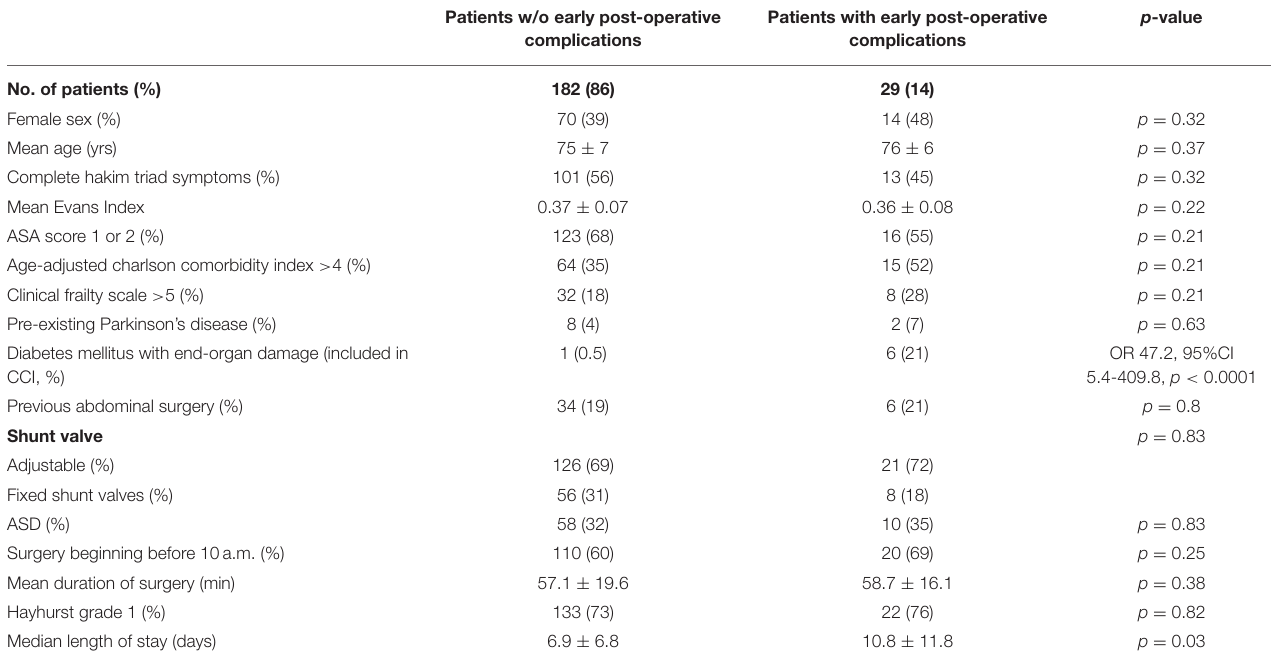
TABLE 3 | Comparison of patients with and w/o early post-operative complications.